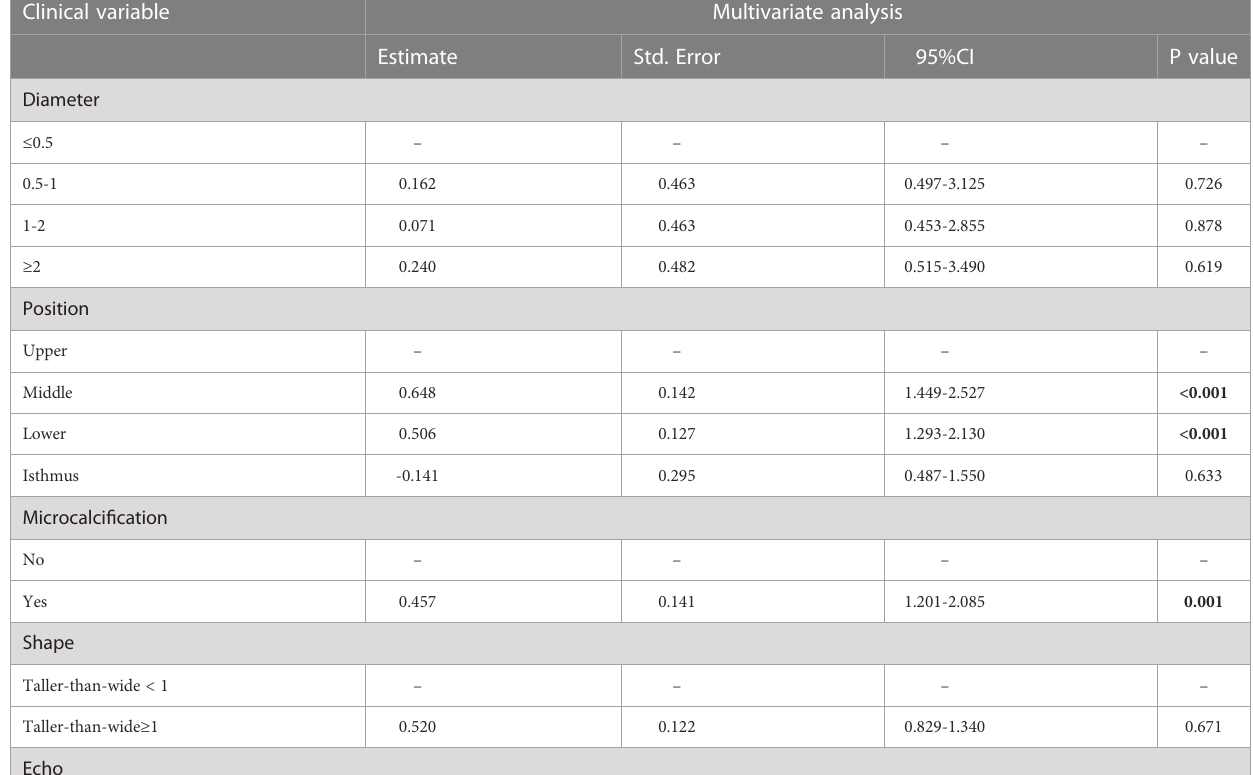
TABLE 2 Risk factors for central lymph node metastasis in the training